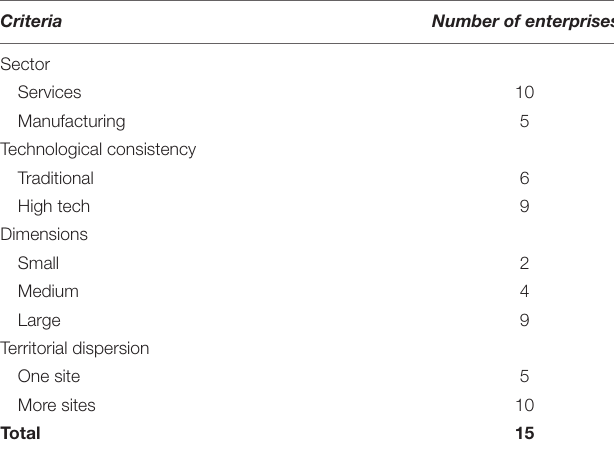
TABLE 1 | Profiles of involved